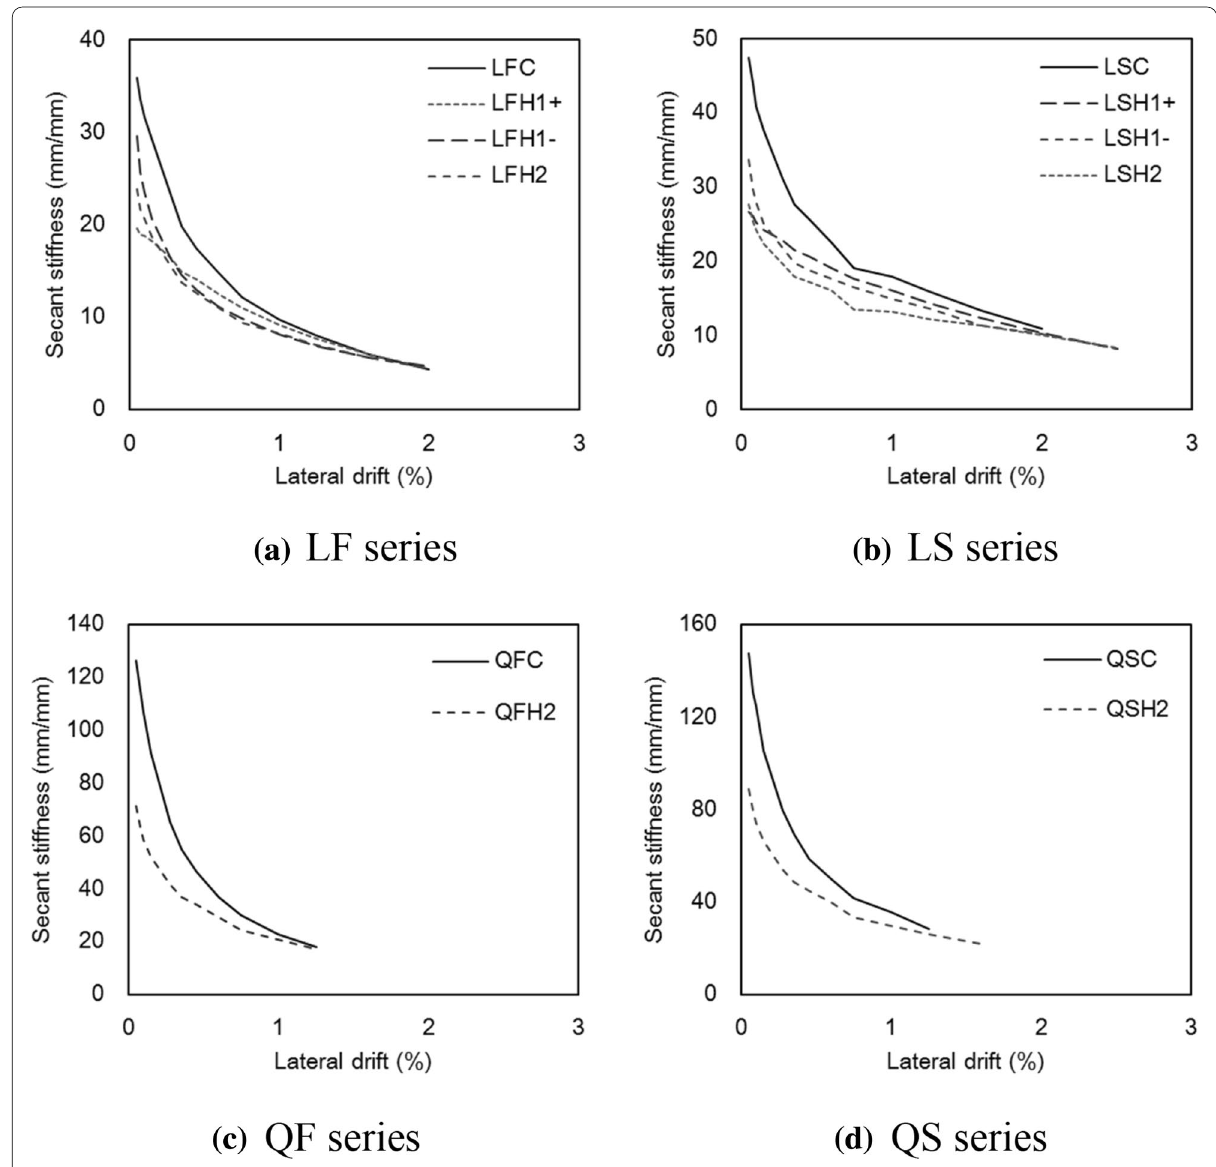
Fig. 13 Stiffness degradation curves of the tested